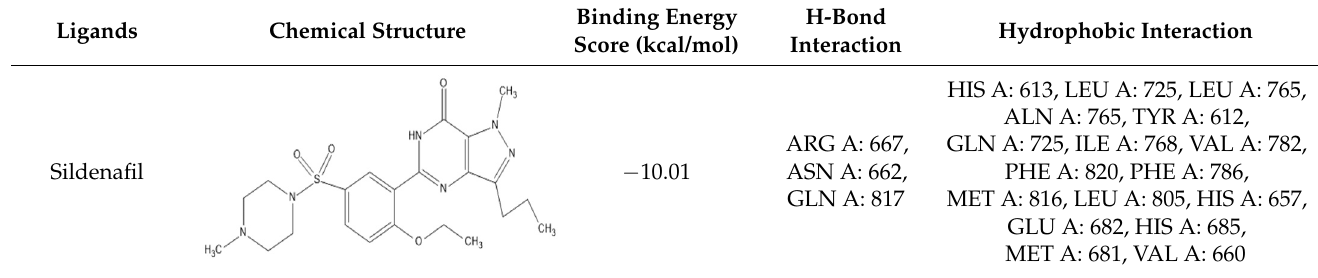
Table 1. Summary of the selected constituents and the reference compound sildenafil into the active site of PDE-5, chemical structures, AutoDock vin docking scores, hydrogen bond interactions, and close contact residues.